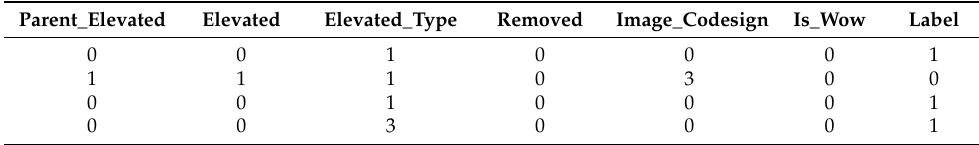
Table 2. Part of normal and abnormal behavior data.